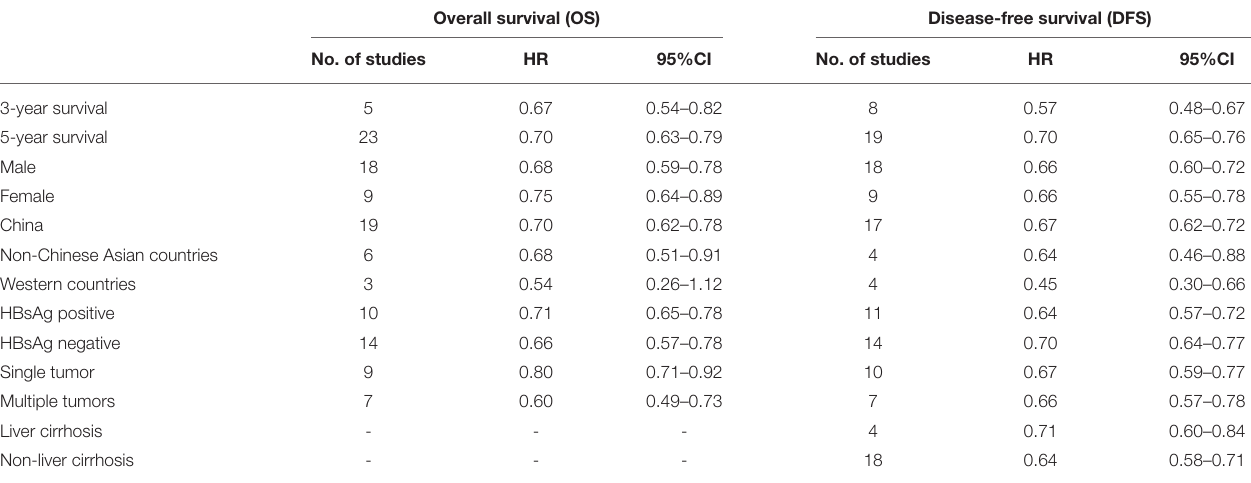
TABLE 2 | Subgroup analysis of the resection margin on the prognosis of patients with HCC.